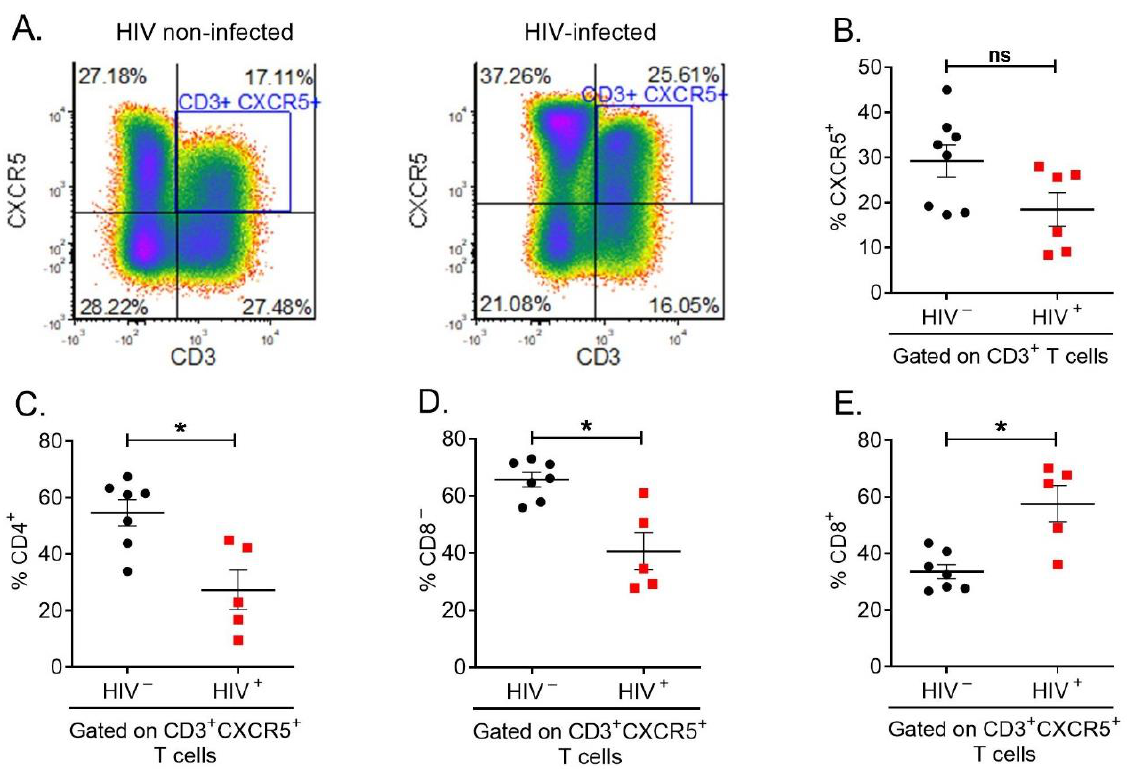
Figure 3. CD4 + CXCR5 + T cells can be detected in long-term-frozen human PBMCs. Previously frozen and then thawed PBMC samples from the MACS were stained with antibodies against CD3, CXCR5, CD4, and CD8. ( A ) Representative flow-plots from an HIV-non-infected individual (left) and an HIV-infected individual (right), showing CXCR5 + CD3 + population within total human PBMCs. The cursors were set in each sample based on the IgG control ( B ) Quantification of CXCR5 expression within the CD3 + T cells. HIV− ( n = 8, mean ± SEM), HIV+ ( n = 6, in red, mean ± SEM), Mann – Whitney U test, ( p = 0.0593, ns). ( C ) Quantification of CD4 expression within the CXCR5 + CD3 + T cells. ( D ) Quantification of CD8 − population within the CXCR5 + CD3 + T cells. ( E ) Quantification of CD8 expression within the CXCR5 + CD3 + T cells. ( C – E ) HIV− ( n = 8, mean ± SEM), HIV+ ( n = 5, in red, mean ± SEM), Mann – Whitney U test (* p < 0.05).